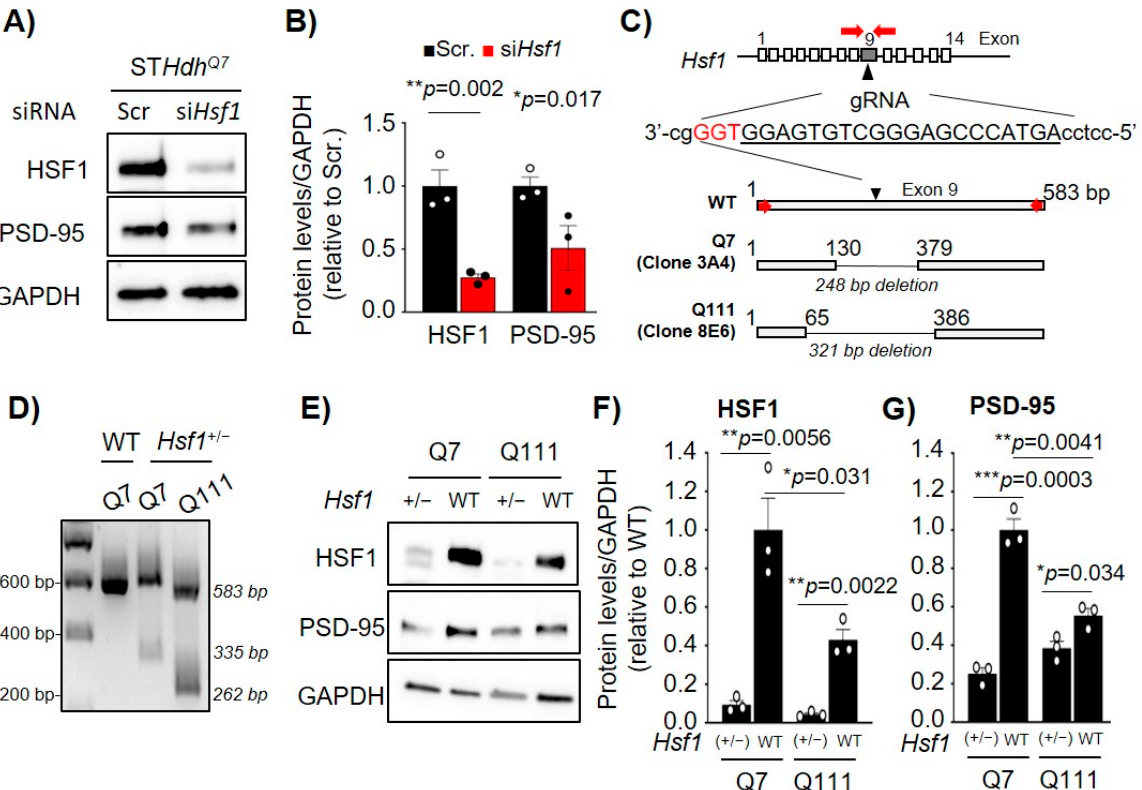
Figure 2. Acute or chronic reduction of HSF1 levels decreased PSD-95 levels in immortalized striatal cells. ( A ) Immunoblot of ST Hdh Q7 cells transfected with non-targeting siRNA (Scr.) or si Hsf1 . GAPDH is used as a loading control. ( B ) HSF1 and PSD-95 protein levels quantified from ( A ) using ImageJ analyses. Data was normalized to GAPDH levels and relativized to Scr ( n = 3), Scr (black), and siHsf1 (red). ( C ) Genetic diagram representing the generation of Hsf1 heterozygous (+/ − ) ST Hdh cell lines using CRISPR/Cas9. Guide RNA (gRNA) targets position +174 within exon 9 of Hsf1 . Cas9 cleavage generated a 248bp deletion in ST Hdh Q7 (clone 3A4) and a 321bp deletion in ST Hdh Q111 (clone 8E6). ( D ) PCR analyses from genomic DNA obtained from WT, clone 3A4, and clone 8E6 for Hsf1 exon 9 DNA region. ( E ) Immunoblotting for WT and ST Hdh cell lines lacking one allele of Hsf1 . GAPDH was used as a loading control. ( F ) HSF1 and ( G ) PSD-95 protein levels quantified from ( A ) using ImageJ analyses. Data was normalized to GAPDH levels and relativized to WT ( n = 3). Error bars denote mean ± SEM. One-way ANOVA with Fisher’s LSD correction in ( B ), unpaired Student’s t -test in ( F ), ( G ). * p < 0.05, ** p < 0.01, *** p < 0.001. Uncropped blots can be found in Supplementary materials (Supplementary Figure S4).